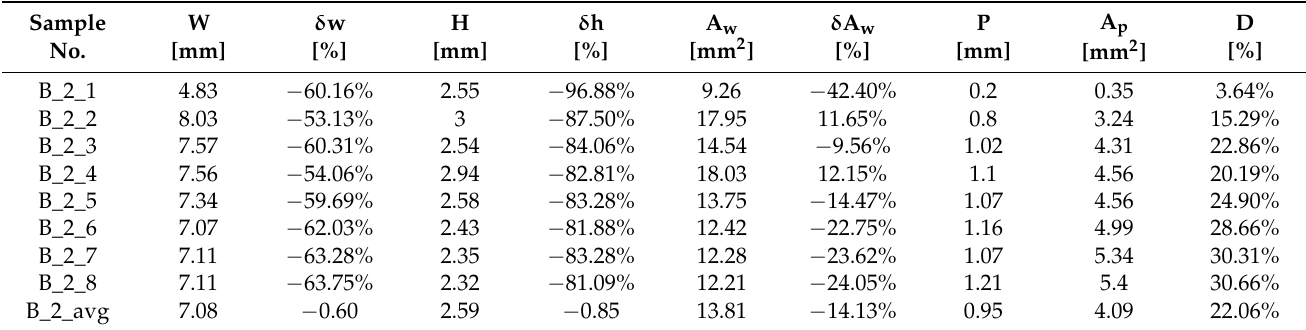
Table A7. Measurements of dimensional features of 2nd parameter set of Wire B—wire feed